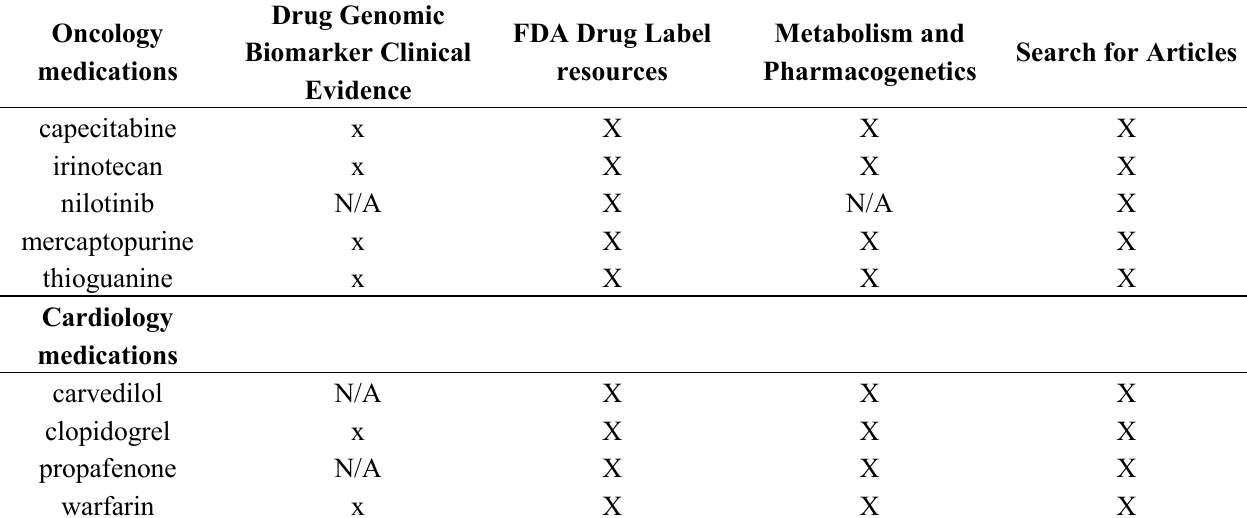
Table 2. Content subsections represented within websites generated using OpenInfobutton for nine medications. ―X‖ indicates all relevant resources, ―x‖ indicates at least one (but not all) relevant resources, and ―N/A‖ indicates no relevant resources were available for a particular medication and content